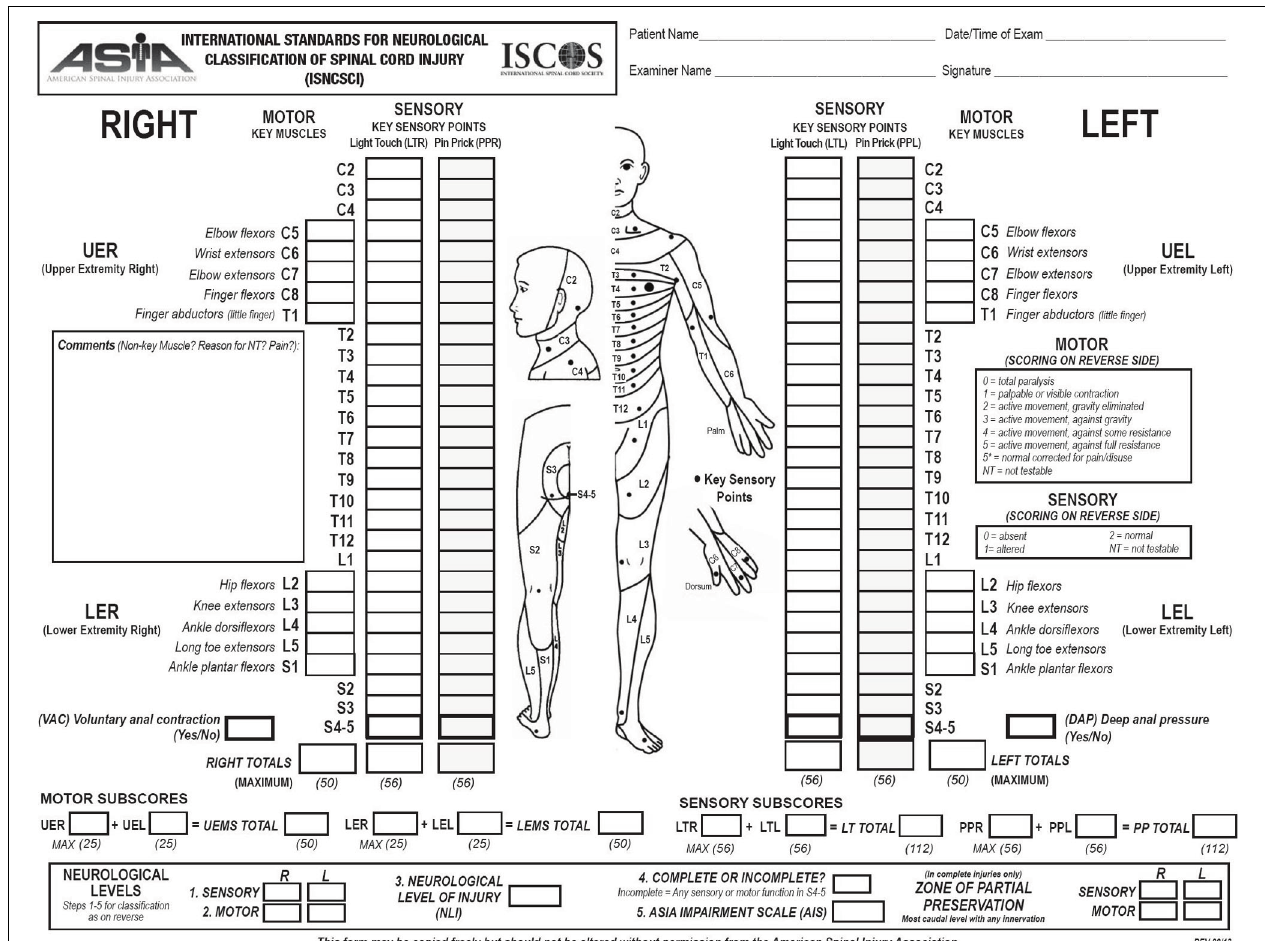
FIGURE 1 | Scoring sheet for the International Standards for Neurological Classification of Spinal Cord Injury. American Spinal Injury Association: International Standards for Neurological Classification of Spinal Cord Injury, revised 2013; Atlanta, GA. Reprinted